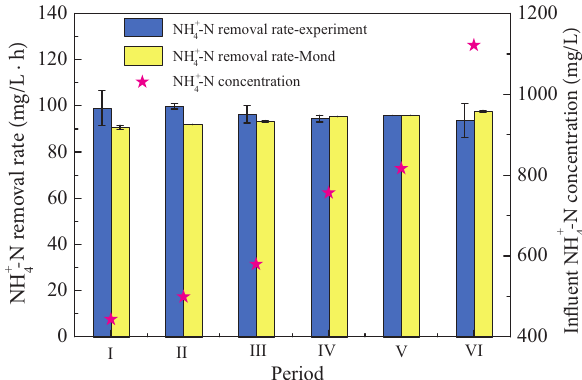
Figure 3. NH 4+ -N removal rate of Monod model at different NH 4+ -N concentration in comparison with the lab